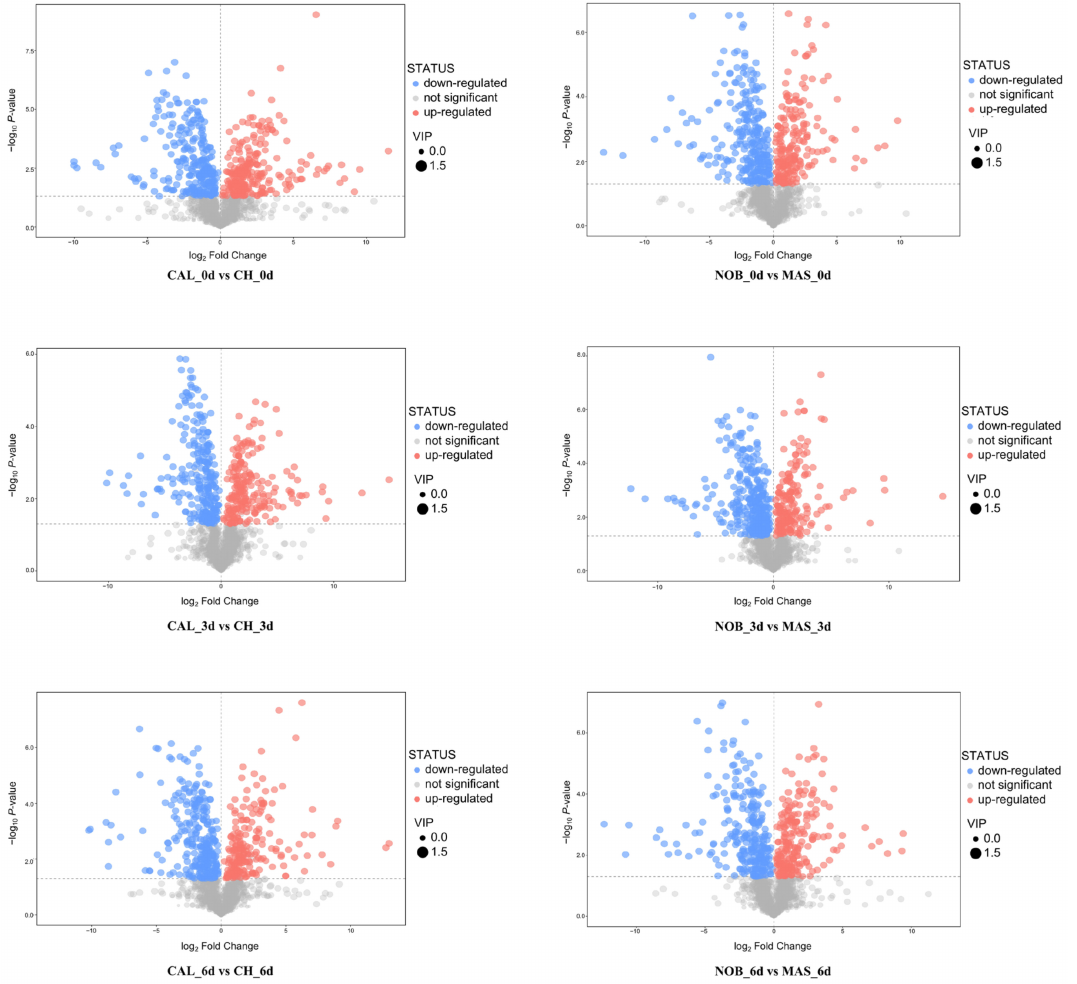
Figure 3. SCMs in different comparison groups during the oxidation